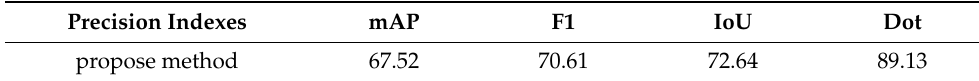
Table 1. The accuracy indexes of the text results of DOTA 1.5.